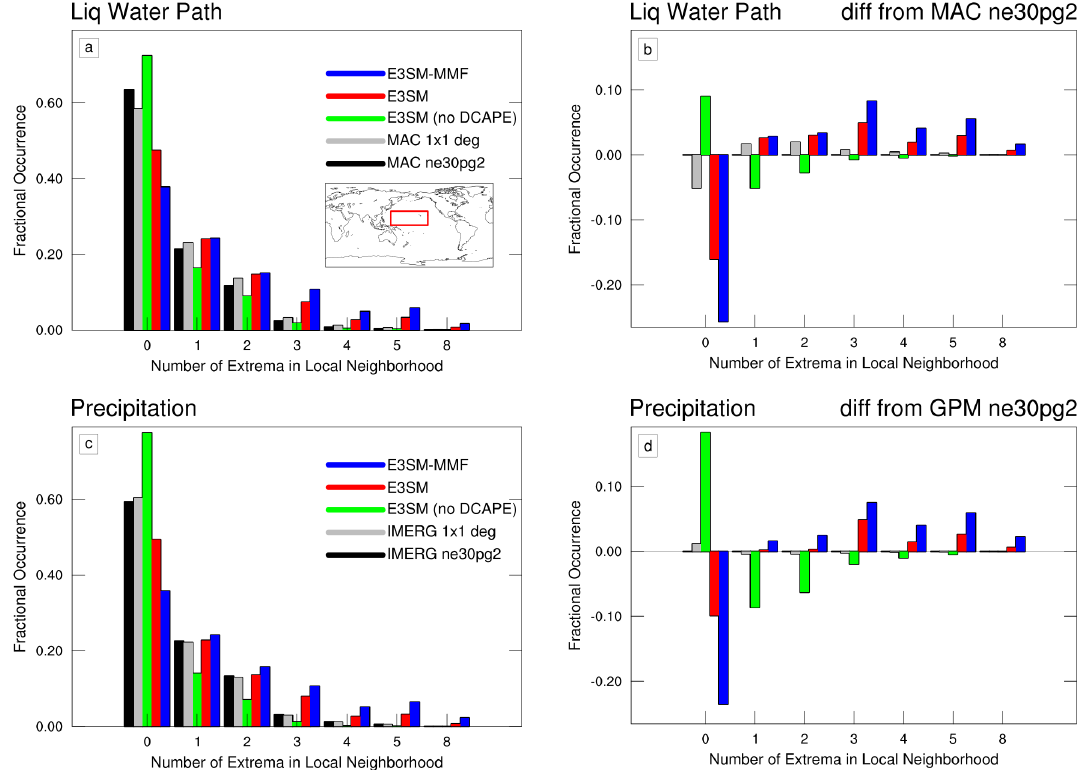
Figure 7. (a, c) Fractional occurrence of neighborhood patterns combined according on the number of local extrema (see text) over the region 0–30 ◦ N, 140–220 ◦ E (see inset map) for 5 years of satellite and model data. Results for IMERG precipitation and MAC liquid water path are shown on a 1 × 1 ◦ grid and the ne30pg2 grid used by the model for direct comparison. (b, d) Difference in fractional occurrence relative to satellite data on the ne30pg2